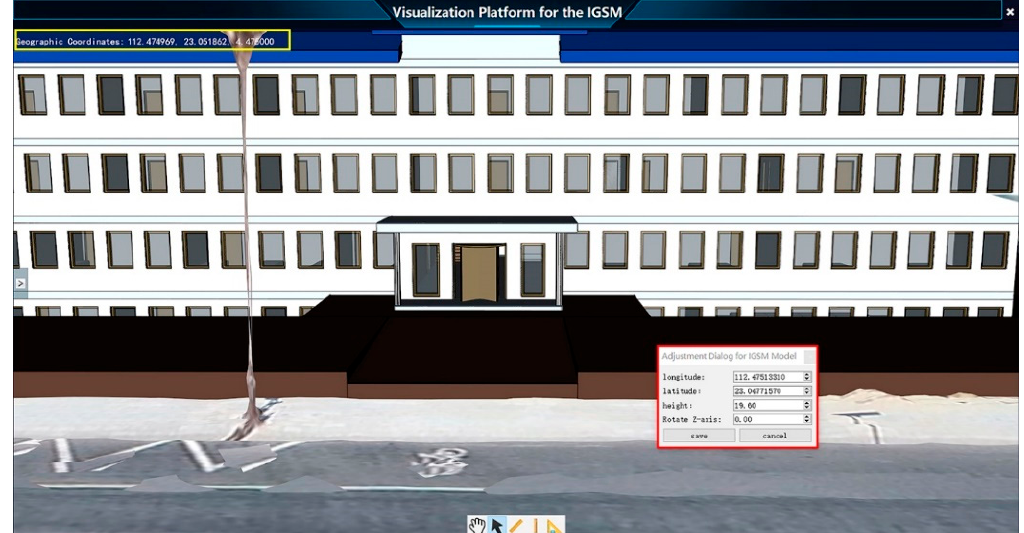
Figure 15. Close-up display effect of the IGSM in the virtual globe (sample data from Table 2. Office Building).